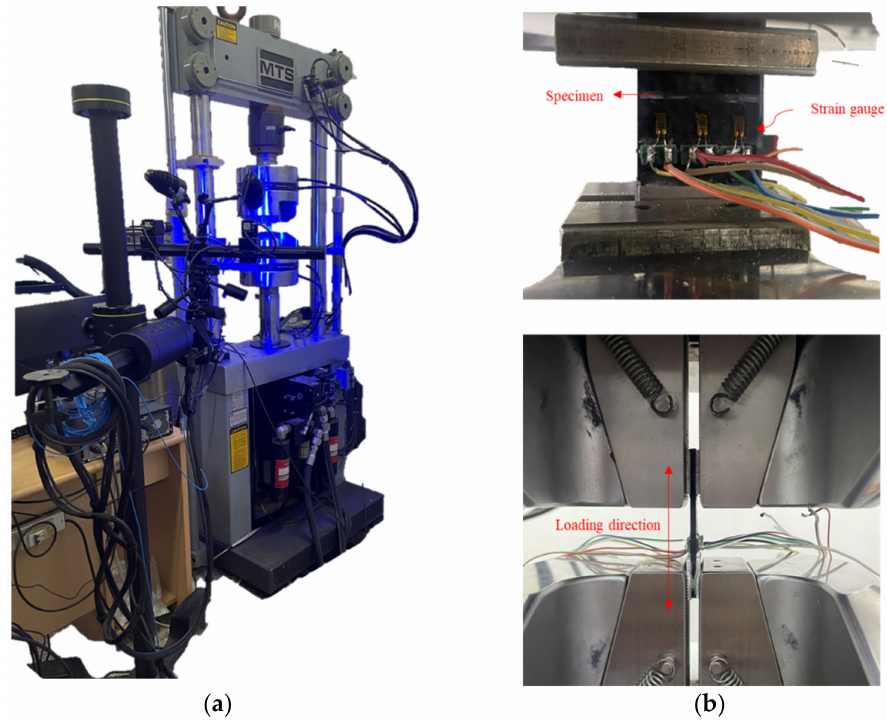
Figure 3. Quasi-static compression tests: ( a ) DIC and MTS 810.25 tester; ( b ) strain gauges and